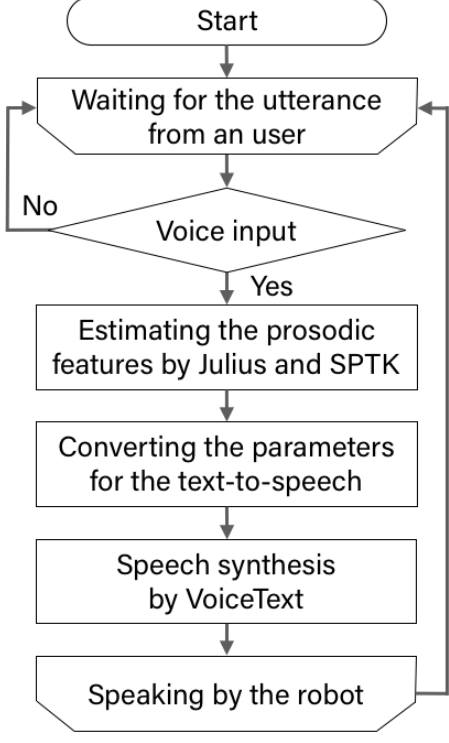
Figure 1. The processing flow of our model. Table 1. Calibration formulas for each prosodic feature and